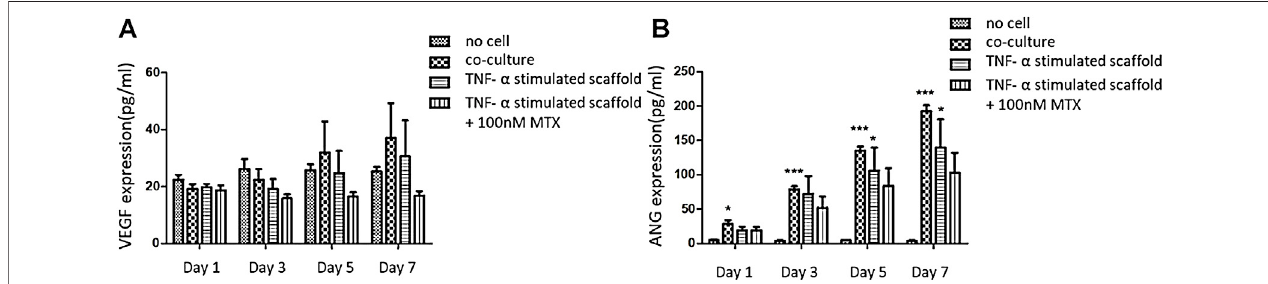
FIGURE 5 | Concentration of VEGF and ANG secreted protein in the supernatant of the three-dimensional scaffold on Day 1, 3, 5, and 7. (A) A. VEGF secreted protein concentration (pg/ml); (B) ANG secreted protein concentration (pg/ml).